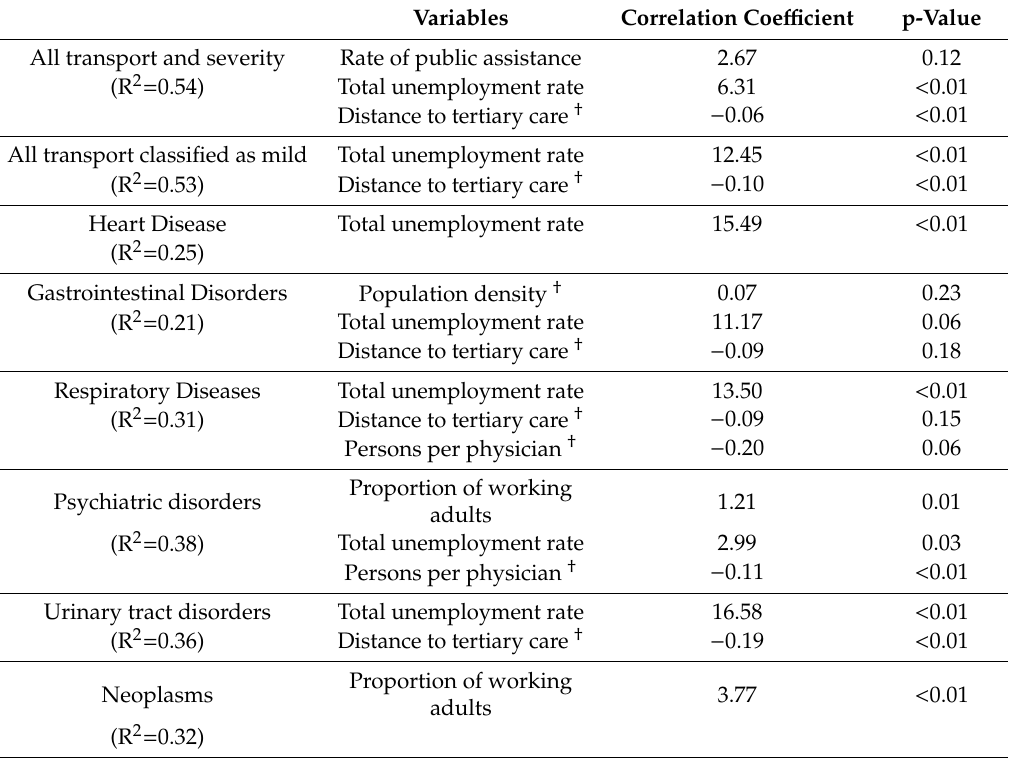
Table 2. Multivariate liner regression models: socioeconomic and health care-associated variables remaining in the final model and correlation with the standardized transport